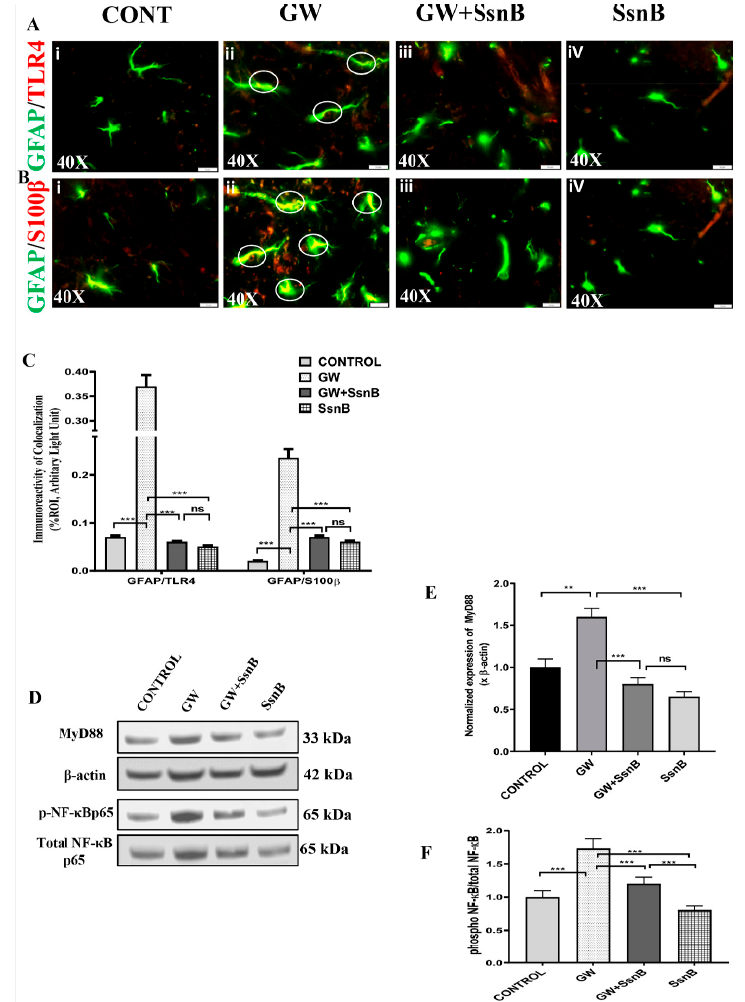
Figure 7. Treatment with SsnB attenuates GW chemical-induced HMGB1 mediated TLR4 activation and inflammation in the hippocampal region in the GWI mouse model. Increased serum expression of HMGB1 in the GW chemical treated mouse group suggests that HMGB1 may cause inflammation in ectopic sites. Colocalization study of TLR4 (red) / GFAP (green) (Figure 7A) and S100B (red) / GFAP (green) (Figure 7B) was performed using immunofluorescence microscopy in the hippocampal region in the brain of CONT ( n = 3) (wild-type mice which were treated with vehicle), GW ( n = 3) (GW chemical exposed group), GW + SsnB ( n = 3) (group exposed with GW chemicals and SsnB), and SsnB ( n = 3) (group treated with SsnB only). Colocalizations were observed in the astrocytes (labeled with GFAP) as yellow dots and are marked in the representative images by white circles. Images were taken at 40 × magnification. Bar graphs depicting morphometric analysis of TLR4 / GFAP and S100B / GFAP (Figure 7C) colocalizations are represented as mean ± SD of the %ROI (mean value calculated from three separate fields of a section of the small intestine). Significance was analyzed by unpaired T-test where * p < 0.05, ** p < 0.01, *** p < 0.001. Immunoblot analysis was performed using protein extracted from frontal cortex lysates to further study the role of SsnB in the expression of TLR4 signaling molecules MyD88, NF- κ B (total p65 and phosphorylated p65) (Figure 7D). Bar graphs depicting densitometric analysis of MyD88 immunoblot normalized with β -actin represented mean ± SD ( n = 3) (Figure 7E). Bar graphs depicting densitometric analysis of phosphorylated p65 normalized with total p65 (Figure 7F). Significance was analyzed by unpaired T-test where ** p < 0.01, *** p <